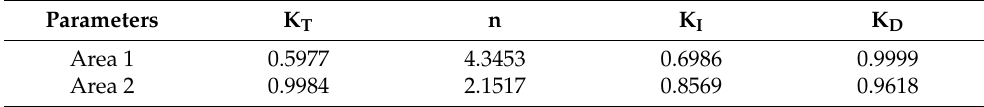
Table 6. TID controller parameters with non-linearities.